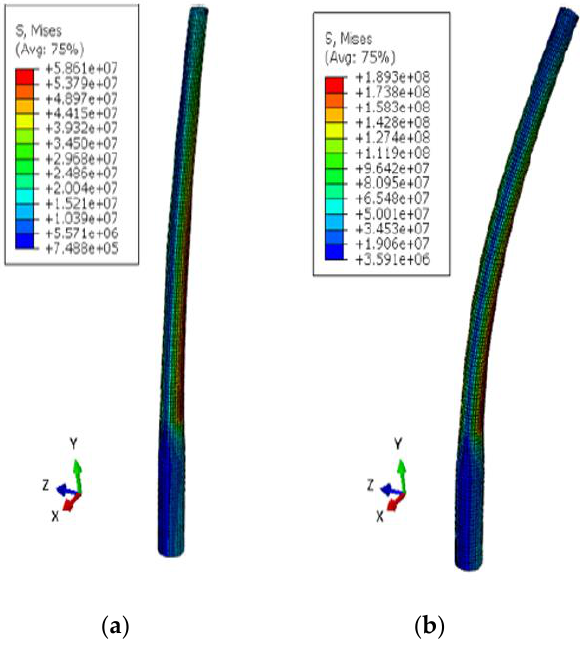
Figure 7. Lateral displacement: ( a ) Normal conditions, ( b ) Extreme sea state.